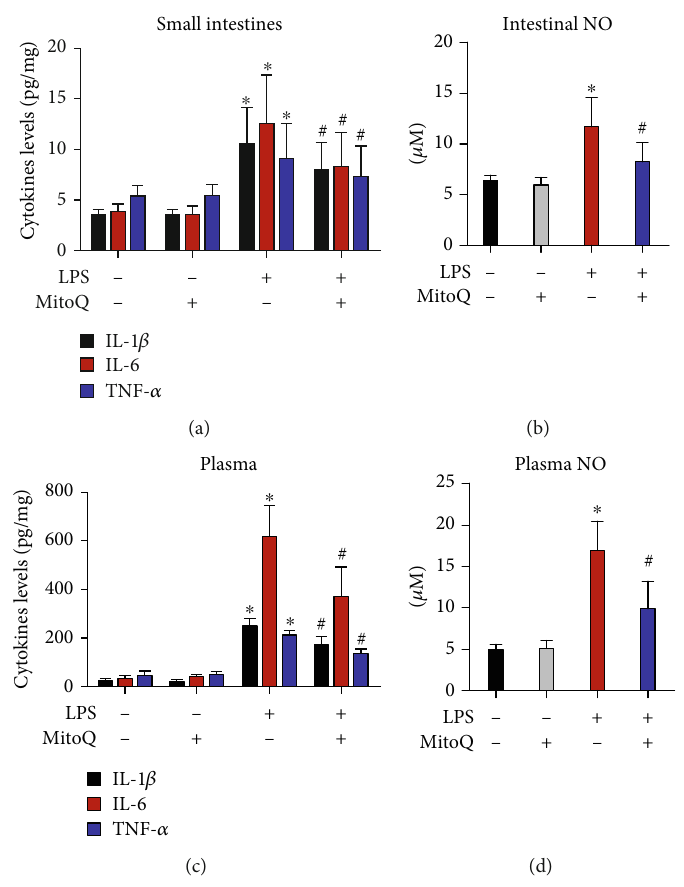
Figure 5: MitoQ decreases intestinal and systemic in fl ammatory agents in sepsis. In fl ammatory cytokines in plasma (a) and intestines (b) were measured by ELISA kits. Plasma and intestinal NO levels were evaluated by Griess Reagent kit. Data are expressed as the mean ± SD . ∗ P < 0 : 05 vs. control group; # P < 0 : 05 vs. LPS